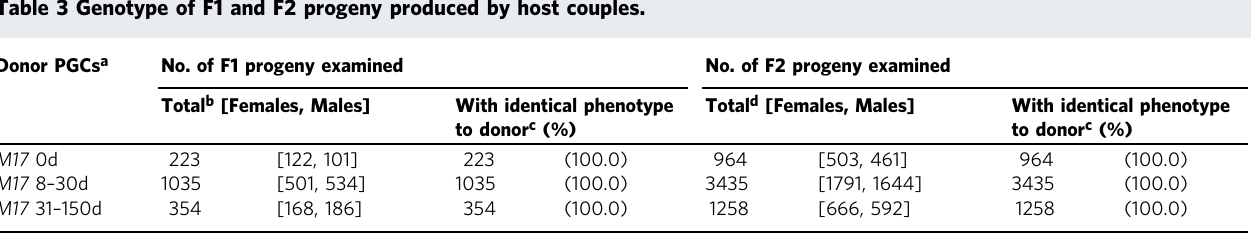
Table 3 Genotype of F1 and F2 progeny produced by host couples.